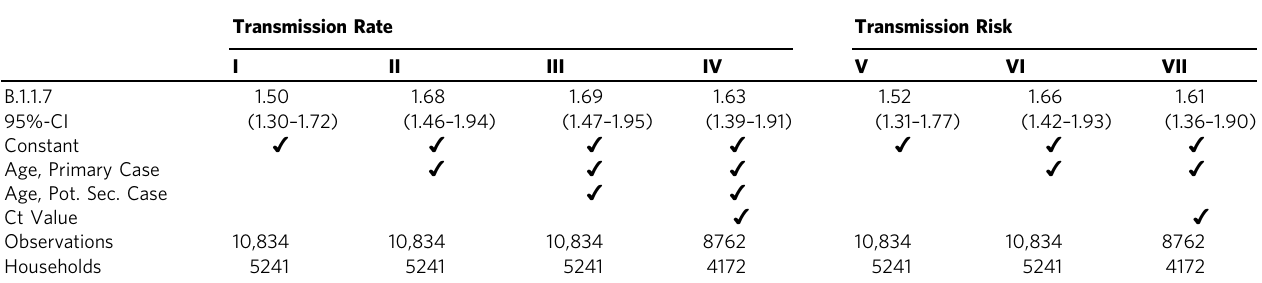
Table 3 Odds ratio estimates for transmissibility for B.1.1.7 compared with other